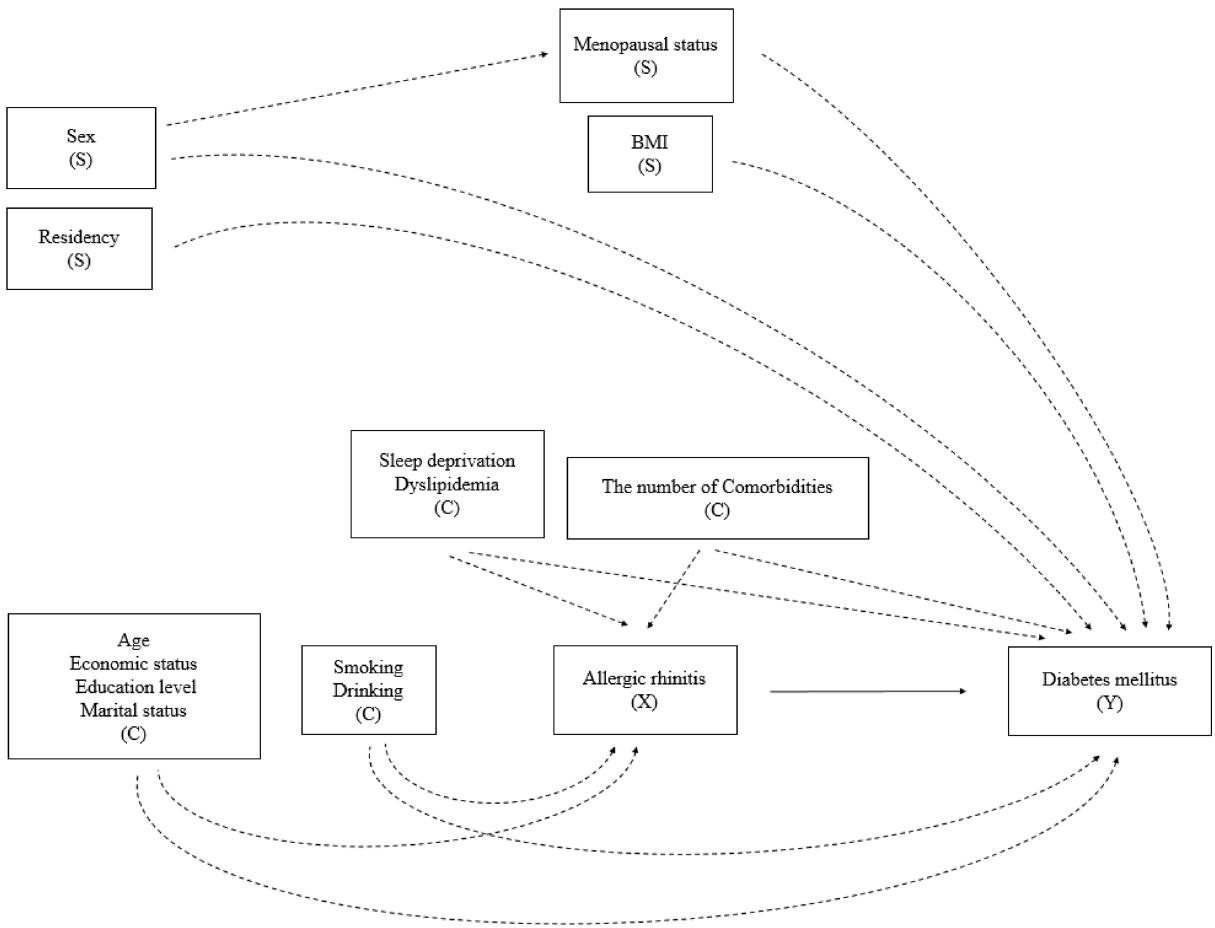
Figure 2. Assumed structure of the association regarding the effects of allergic rhinitis (AR; exposure X) with covariates (C) on diabetes mellitus (DM; outcome Y) with stratification